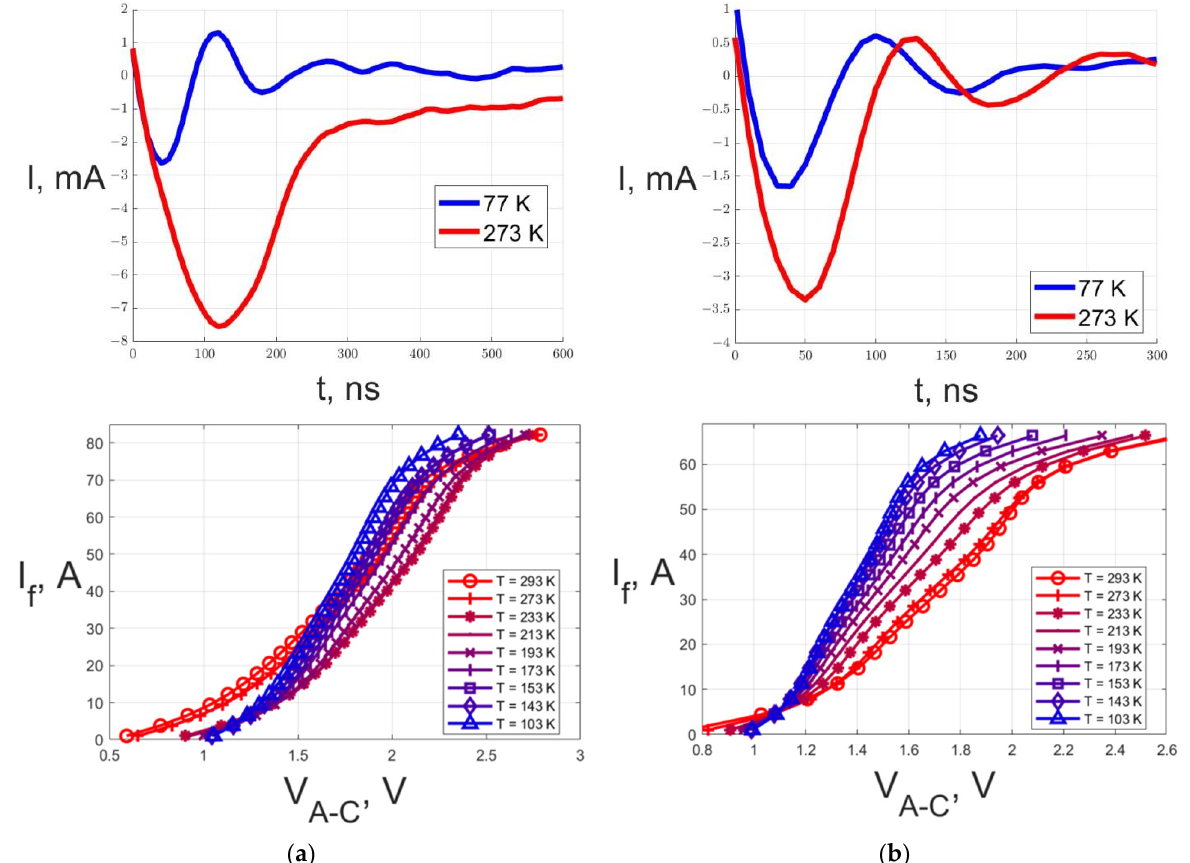
Figure 4. Graphs of the reverse recovery process (top) of the samples and the forward branch of the CVC (bottom) for samples 1 ( a ) and 2 ( b ).